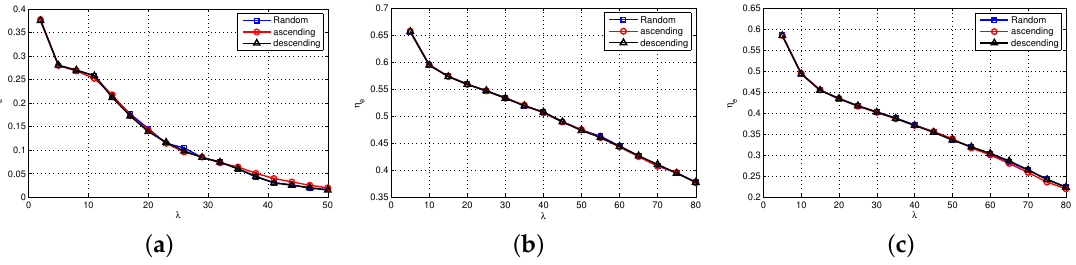
Figure 13. Different processing sequence in SND-lib topologies. ( a ) Abilene. ( b ) India. ( c ) Germany.